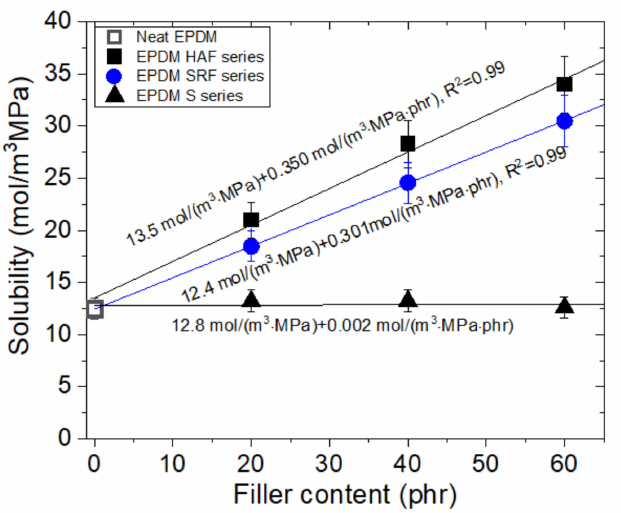
Figure 5. Variation in solubility versus different filler contents for filled EPDM composites. The three slanted lines are linear slopes of hydrogen solubility relative to the filler